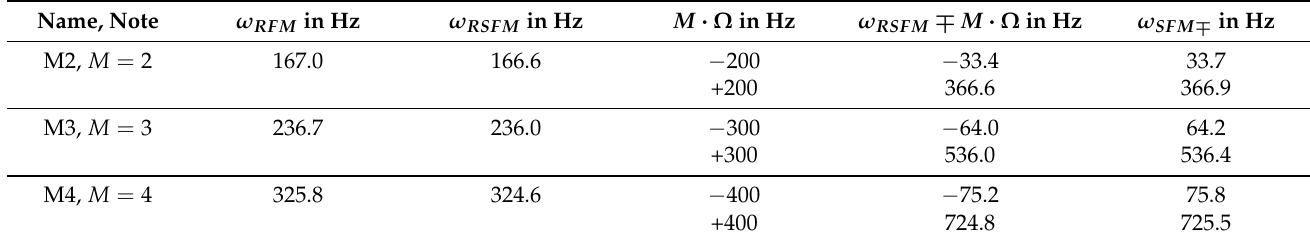
Figure 10. Measured spectra at Ω = 100 Hz. Top : RFM spectrum measured with strain gauge at R = 170 mm. Middle, bottom : SFM and RSFM spectra at R = 237 mm. Table 1. Rotating frame natural frequencies measured with RFM ( ω RFM ) and RSFM ( ω RSFM ). The rotating frame natural frequencies are compared to the backward and forward wave frequencies in the SFM spectrum ω SFM ∓ . By matching the results, the natural frequencies can be assigned to their corresponding modes/number of nodal diameters M